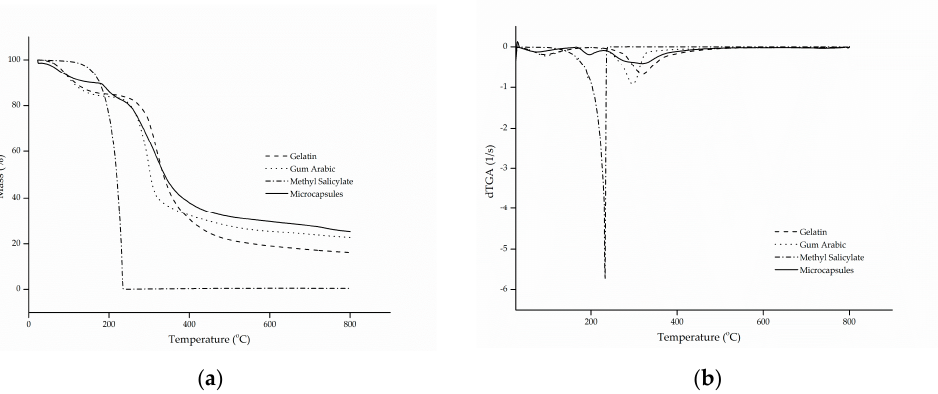
Figure 2. ( a ) thermal stability (TG) and ( b ) thermogravimetric curve (dTG) of gelatin, gum Arabic, methyl salicylate and